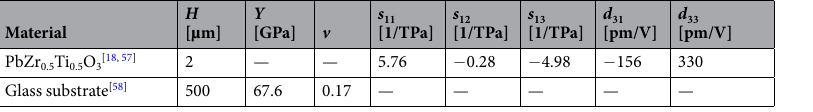
Table 1. Thickness, elastic and piezoelectric parameters of the film and the substrate used in the